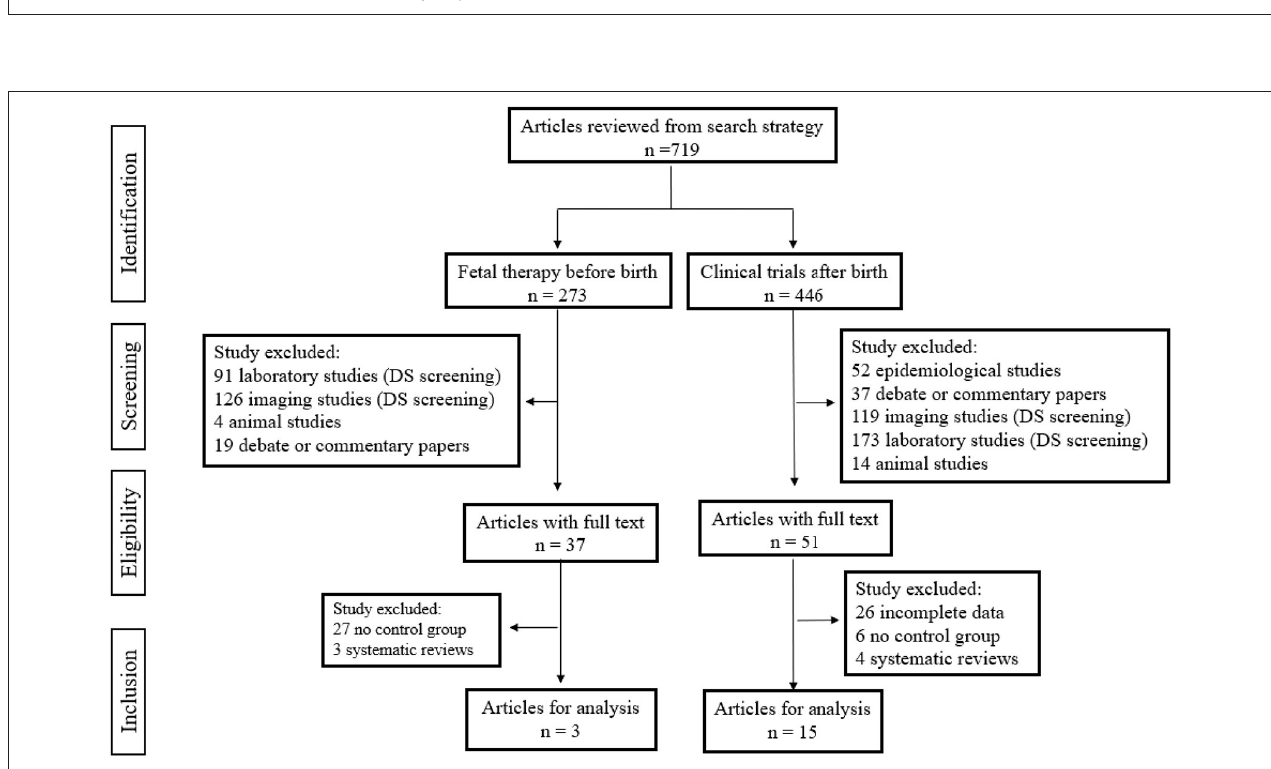
FIGURE 3 | Flowchart. This is a diagrammatic representation of study selection process.